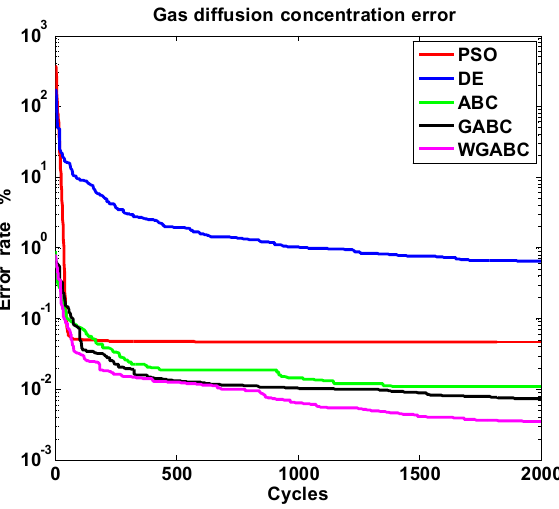
Figure 4. Diagram of error rate of the gas diffusion concentration.